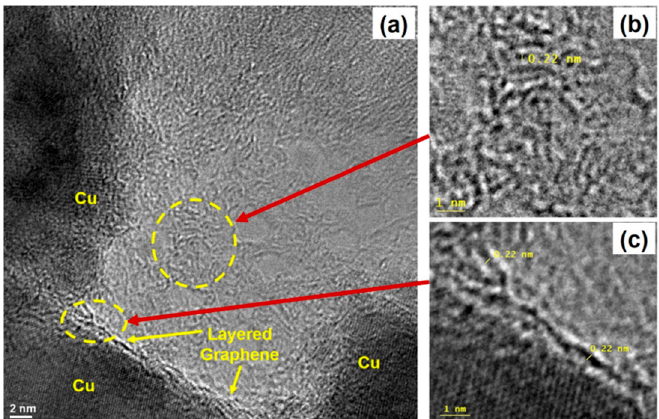
Figure A4. ( a ) High-resolution cross-sectional TEM image of the nanolayered carbon film in a nanoscale hole; ( b ) an enlarged view of the film inside the hole, showing nanolayered structures; ( c ) an enlarged view of the film on the interface of Cu substrate, showing nanolayered structures. Scale bar in ( a ): 2 nm; scale bar in ( b , c ): 1 nm.